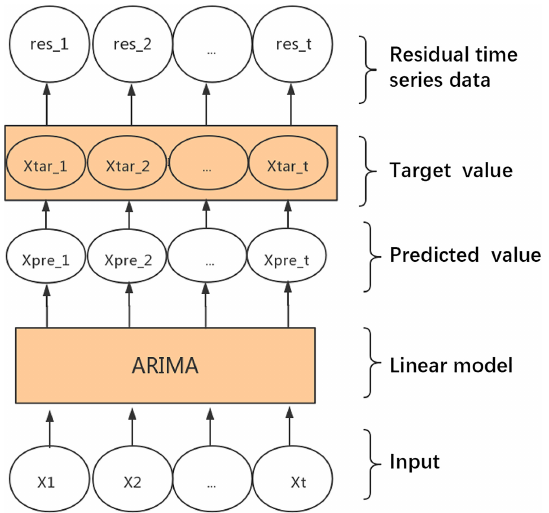
Figure 3. ARIMAfilterseparates linear and non-linear